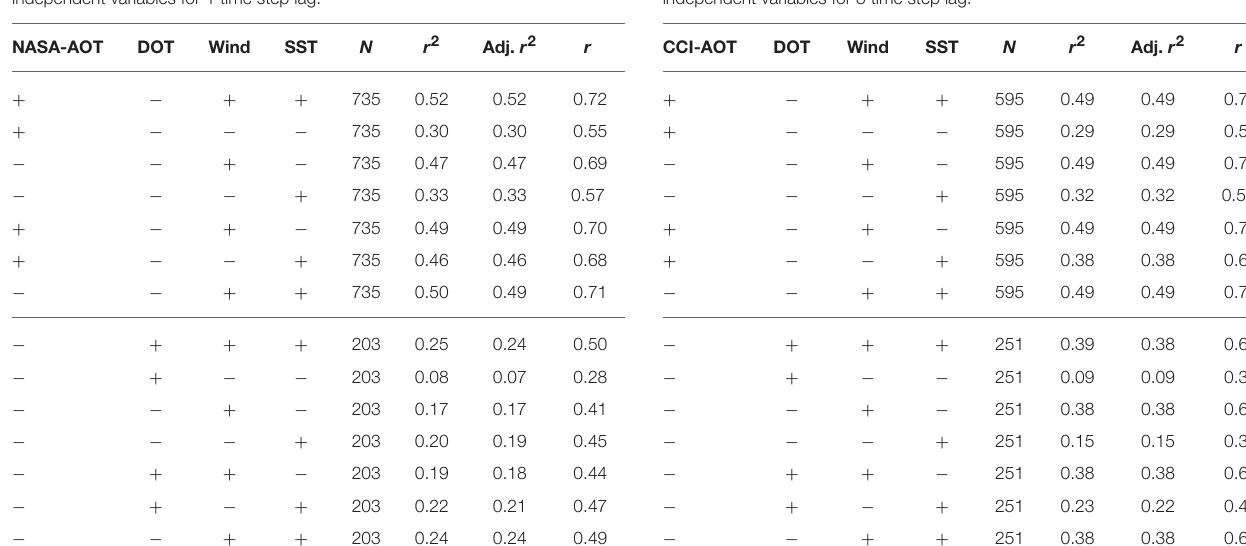
TABLE 5 | Results of multiple linear regression analysis with Chl-a as the dependent variable and CCI-AOT or DOT, alongshore wind speed and SST as independent variables for 3 time step